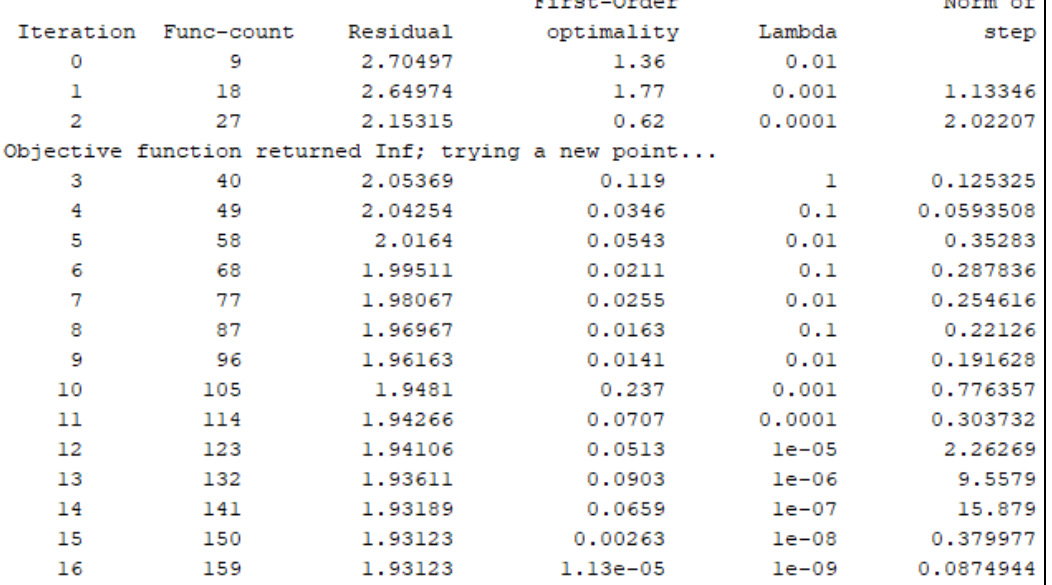
Figure 13. Iterative process offered by the nonlinear least squares (NLS) method.